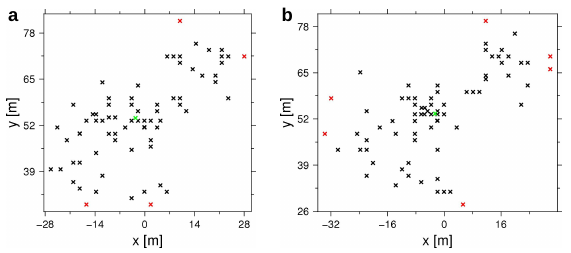
Figure 5. The residual shifts in local stereographic map coordinates x , y of the 79 LOLA tracks to the TC2 DTM from Fig. 3b. Considered residuals are shown as black crosses, outliers are shown as red crosses and the common offset between the DTM and all tracks is shown as a green cross. (a) Original LOLA frame. (b) New LOLA frame.